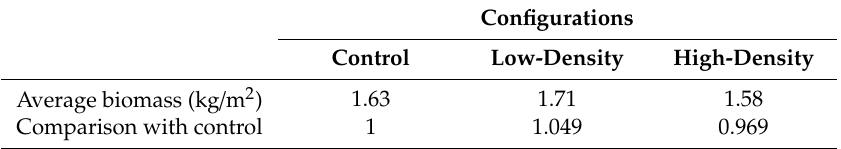
Table 2. Average biomass (dry basis) of corn stover grown in di ff erent configurations.